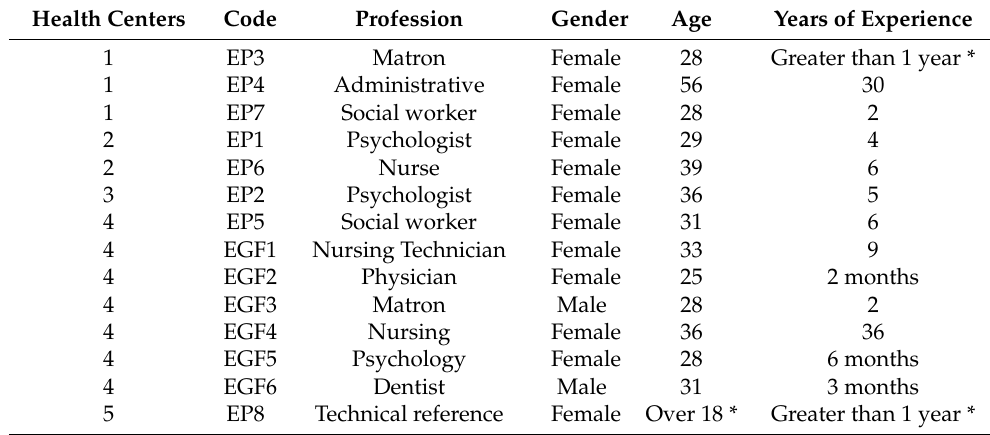
Table 1. Description of study